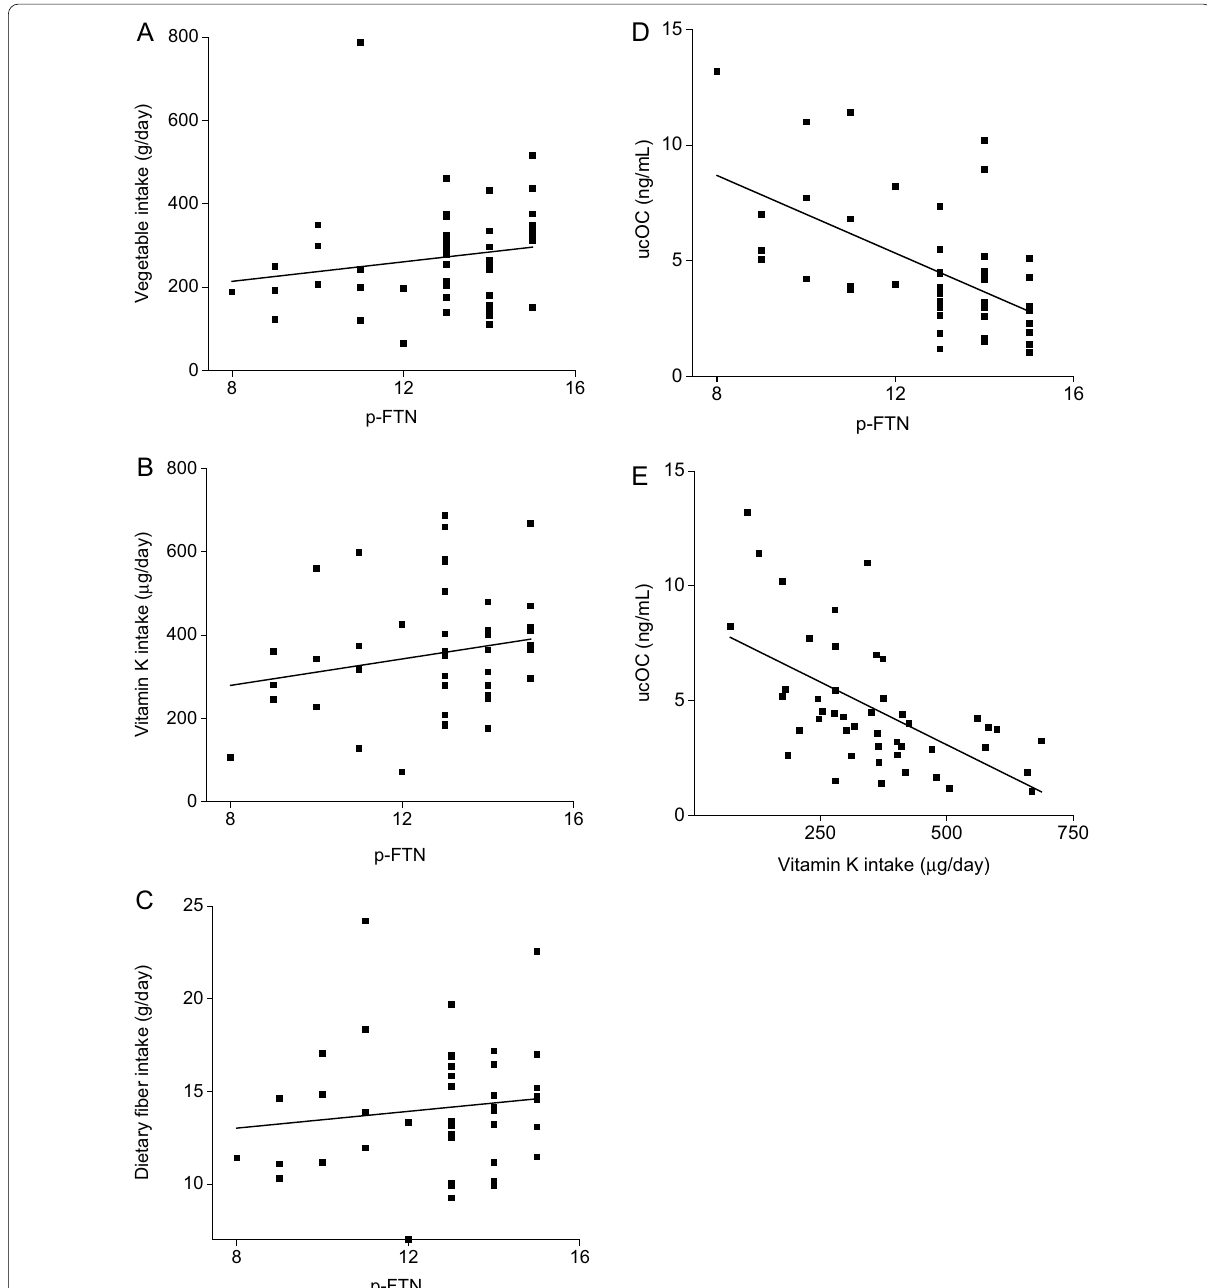
Fig. 1 Correlation between outcomes. A Correlation between p-FTN and vegetable intake ( r vitamin K ( r 0.21, p 0.17). C Correlation between p-FTN and dietary fiber intake ( r = = ( r 0.51, p < 0.001). E Correlation between vitamin K intake and ucOC level ( r = −